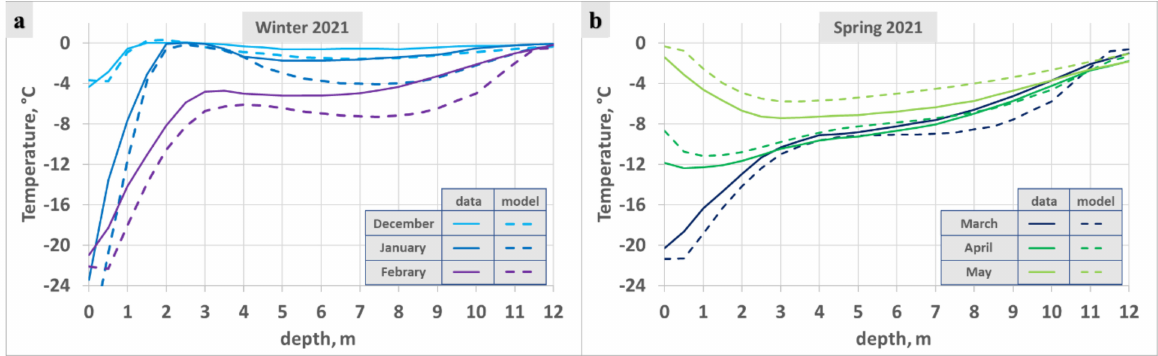
Figure 19. Comparison of temperature profiles in SAM well 48–1 in 2021 in winter ( a ) and spring ( b ).